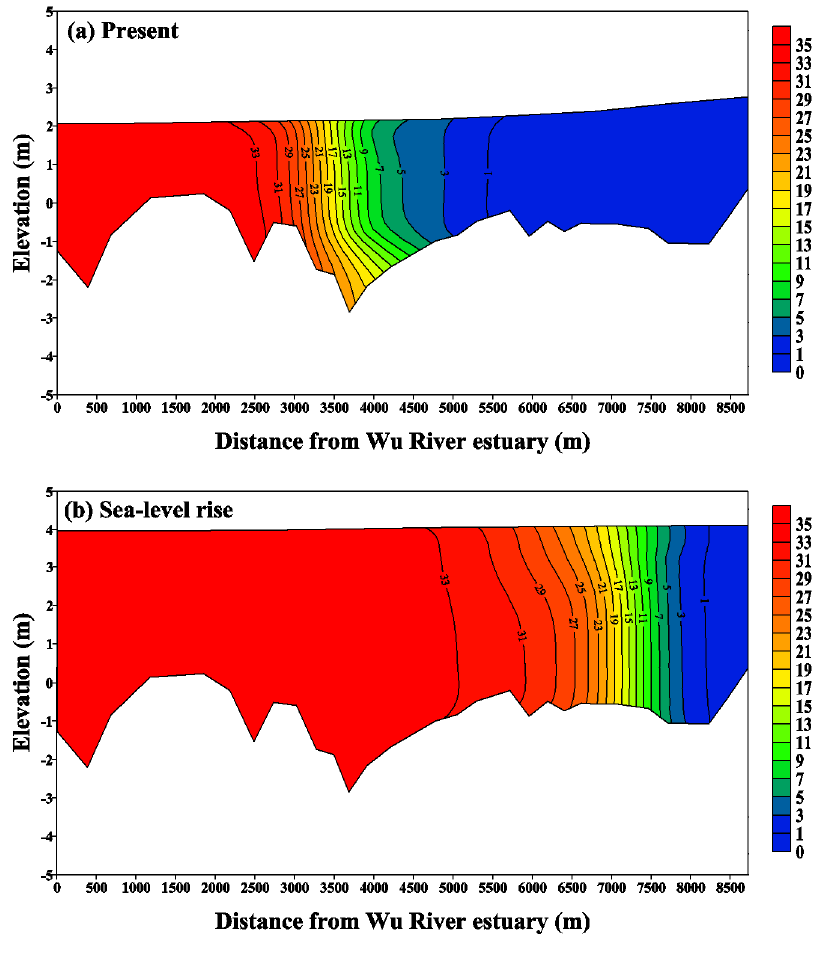
Figure 11. Distribution of the tidal-averaged salinity along the Wu River estuary under the Q flow condition for ( a ) the present condition and ( b ) the sea level rise scenario. Note 90 that the unit of salinity is